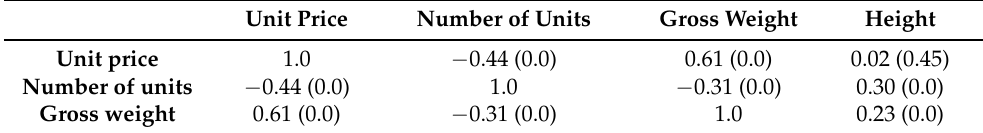
Table 3. Pearson correlation coefficient with corresponding